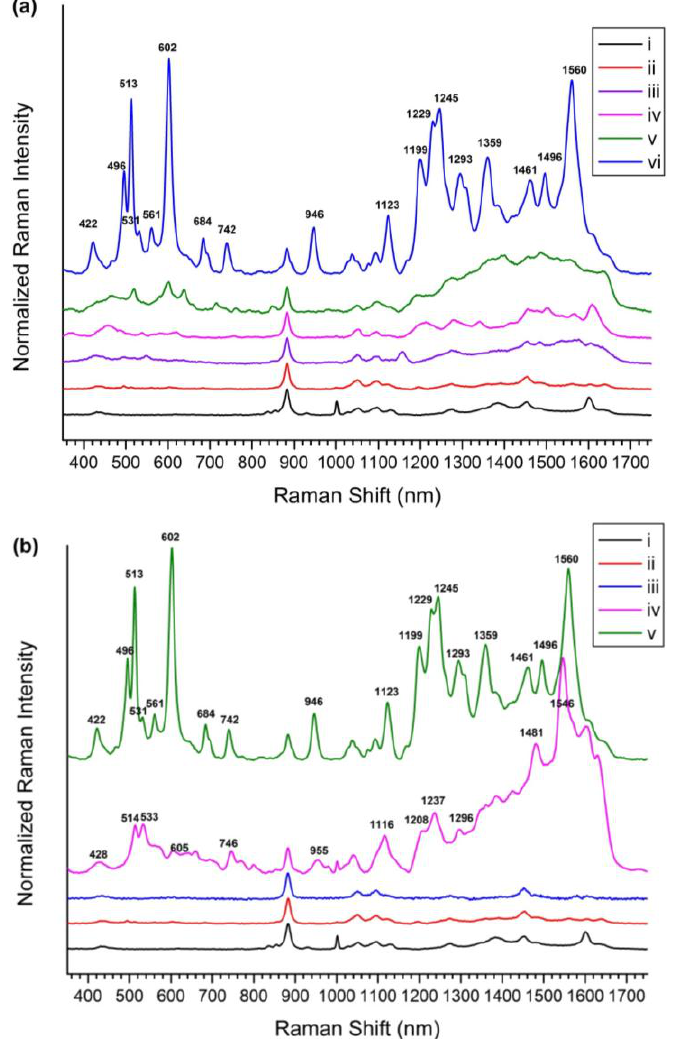
Figure 3. Surface enhanced Raman scattering (SERS) spectra. ( a ) SERS spectra of (i) silver